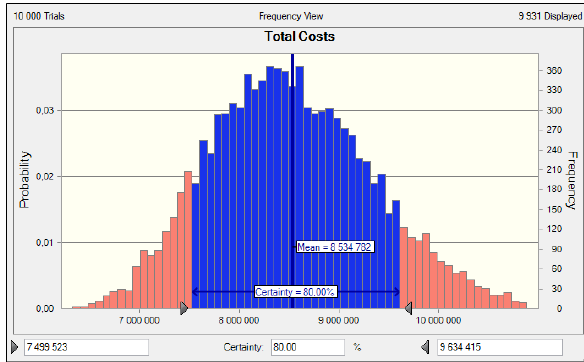
Figure 9: Forecast of Total costs.